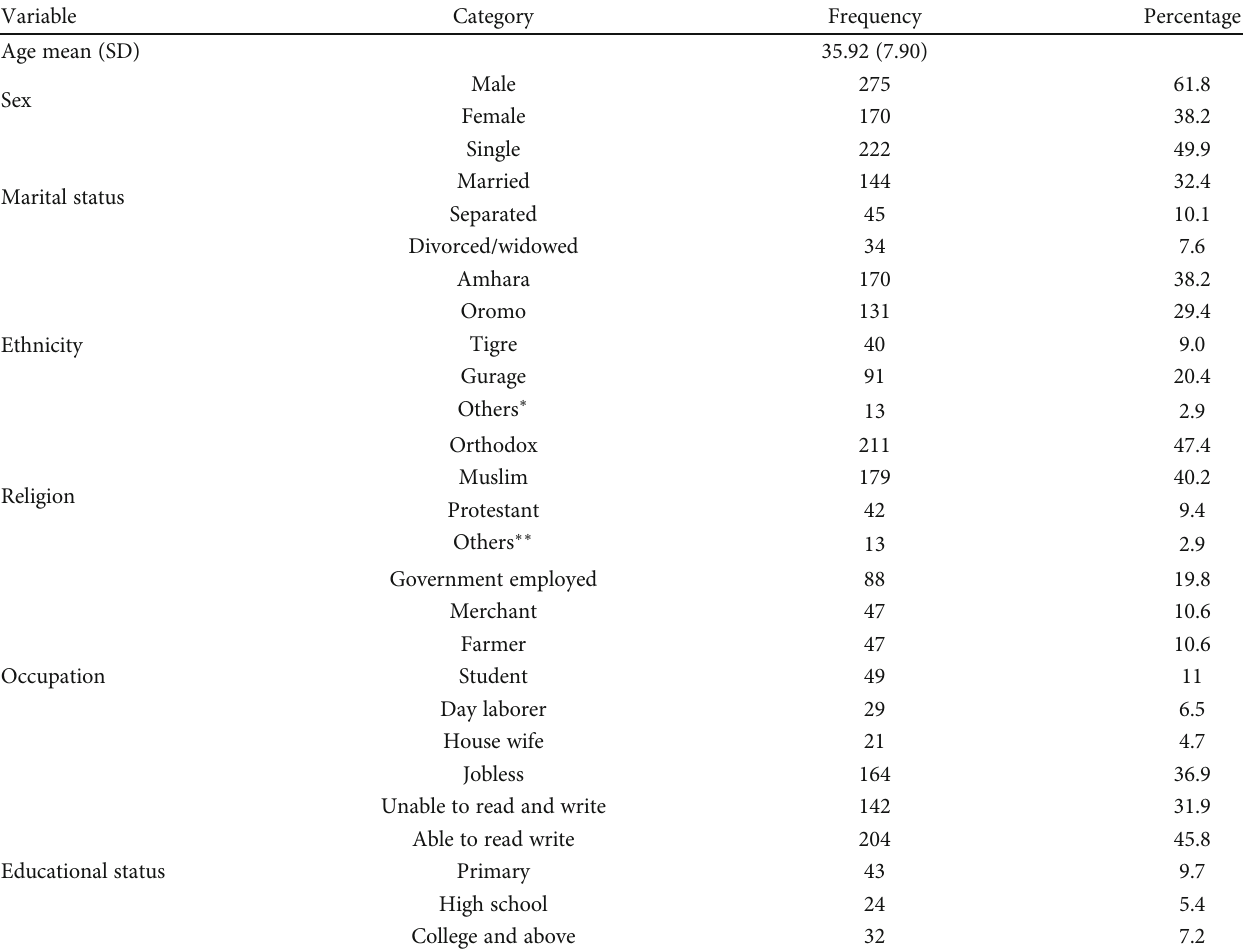
Table 1: Description of sociodemographic characteristics of the patients with schizophrenia in AMSH